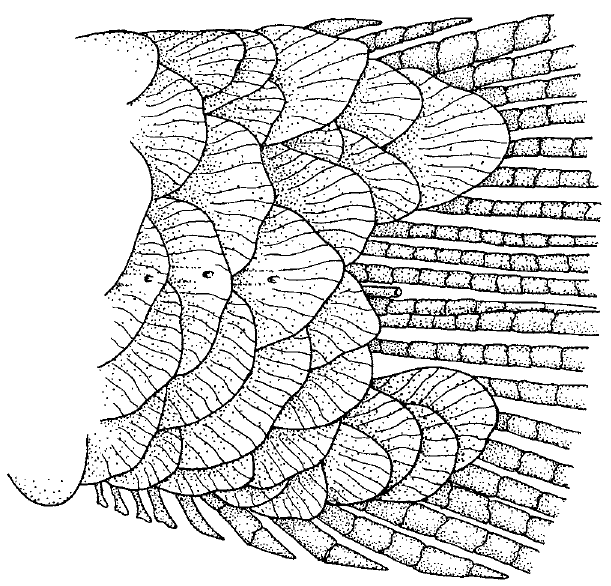
Fig. 13. Knodus meridae , USNM 121469. Type species of Knodus , a non-inseminating species. Caudal-fin squamation. Male, SL 21.0 mm, lateral view left side, portraying scales extended out onto caudal-fin rays. Venezuela: Trujillo, lago Maracaibo basin, río Motáin, 4 km above Motáin.